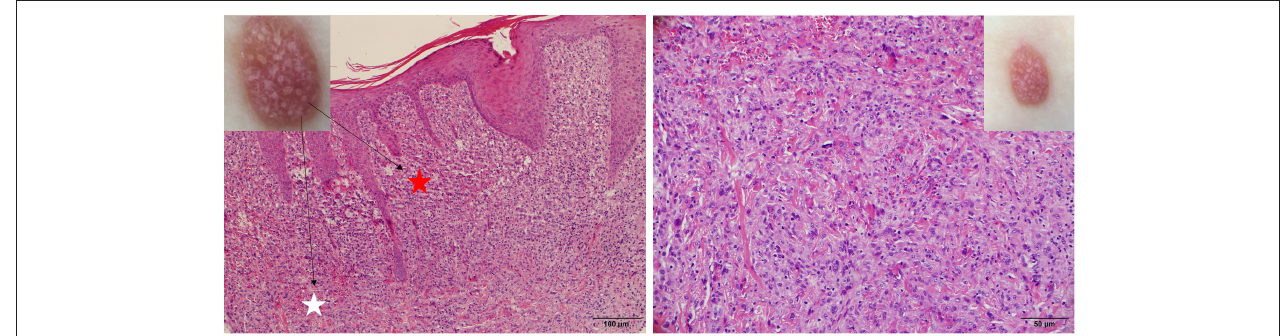
TABLE 1 | The proliferative index of infiltrated histiocytes in JXG with or without linear vessels. Linear vessels ( n = 38)